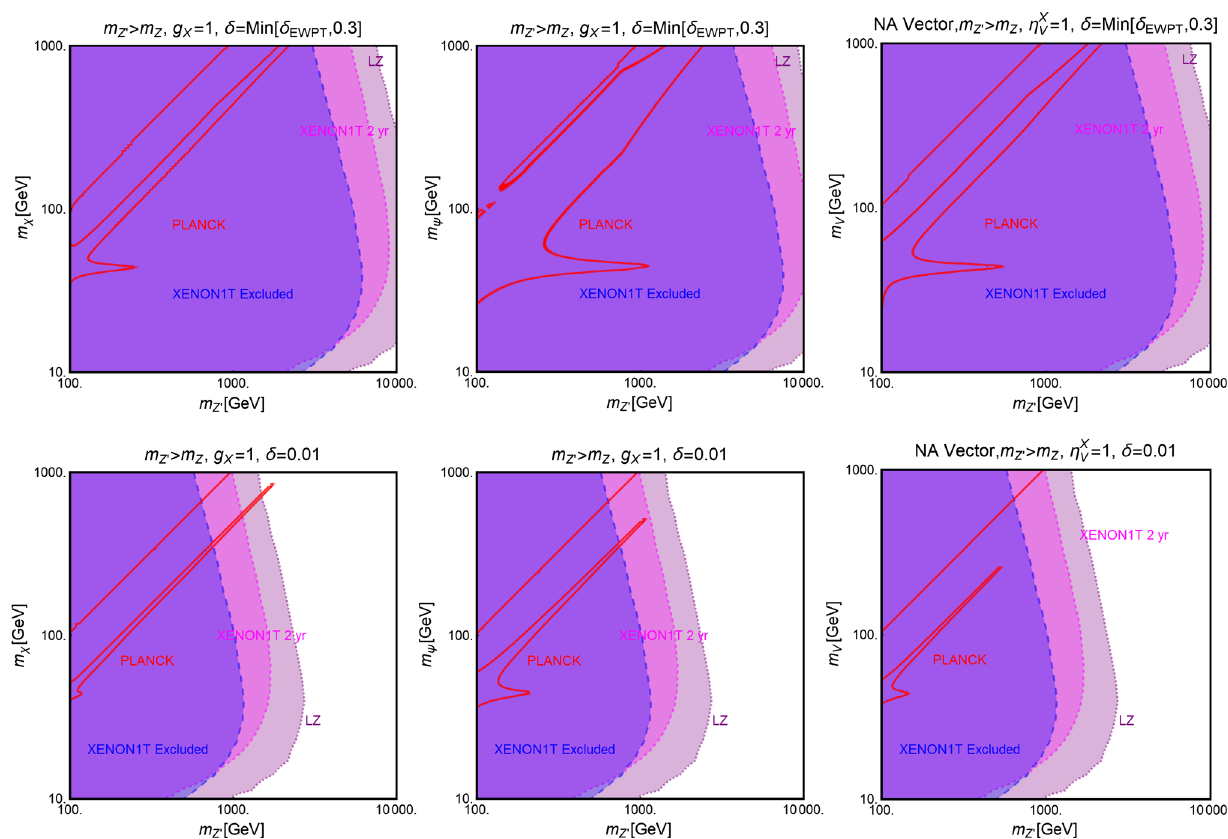
Fig. 22 Combined constraints in the relevant bi-dimensional planes to a constant value of 0 . 01. We set g X = 1 for all these plots. In this ( m , m χ ) , ( m , m ψ ) and ( m , m ) for the scalar (left column), figure the red curve represents the contour of correct DM relic density. V Z (cid:15) Z (cid:15) Z (cid:15) The blue region is excluded by the current constraints from XENON1T fermionic (middle column) and non-Abelian vectorial (right column) while the magenta and purple regions would appear excluded in the DM, respectively, interacting with a Z (cid:15) , kinetically coupled with the absence of signals from XENON1T (after 2 years of exposure) and LZ, SM Z boson. In the top-row plots the kinetic mixing parameter δ has been set to the maximal value, as a function of m Z (cid:15) , consistent with the EWPT constraints while for the bottom-row plots δ has been set